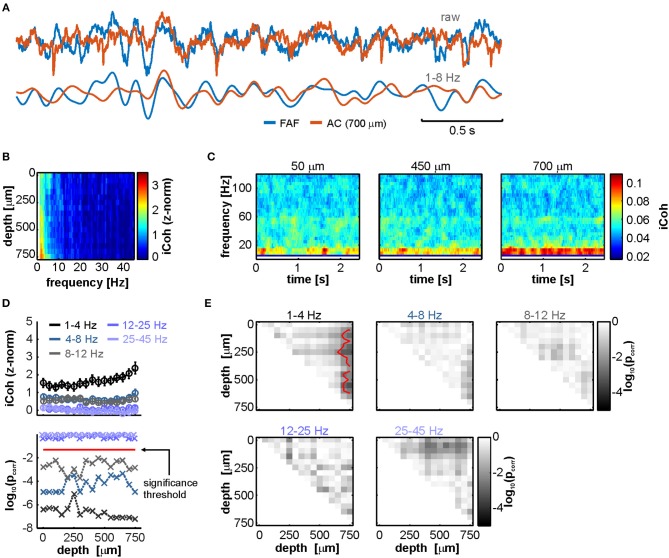
LFPs from FAF and AC are low-frequency coherent during spontaneous activity in a depth-dependent manner. (A) Simultaneously recorded LFP trace from the FAF (blue) and the AC at a depth of 700 μm (orange). Raw (top pair) and low-frequency filtered (bottom pair) traces are shown. (B) Frequency-dependent average imaginary coherence (iCoh), z-normalized to a surrogate distribution, across recording depths in the AC. Deep channels showed, on average, the strongest coherence values at low frequencies. (C) Time-resolved iCoh using the same segments as in (B), with a sliding window of 200 ms (see Methods), the same used for analyzing stimulus-related synchronization. (D)
Top: depth-dependent population z-normalized iCoh from (B), for distinct frequency bands (delta, theta, alpha, beta, and low gamma, see Methods; frequency ranges indicated in the plot), across all penetrations (shown as mean ± SEM). Bottom: log-scaled corrected p-values after testing, per frequency band, whether z-normalized iCoh values were significantly higher than 0 across penetrations, per AC depth (FDR-corrected Wilcoxon signed rank tests, pcorr < 0.05 for significance; threshold indicated as a horizontal red dashed line). (E) Significance matrices comparing, per frequency band, z-normalized iCoh values across different depths. Each cell (i, j) in a matrix depicts the log-scaled pcorr obtained from statistically comparing coherence at channels with depths i and j in the AC. Red contour lines delimit regions of statistical significance (FDR-corrected Wilcoxon signed rank tests, significance when pcorr < 0.05).